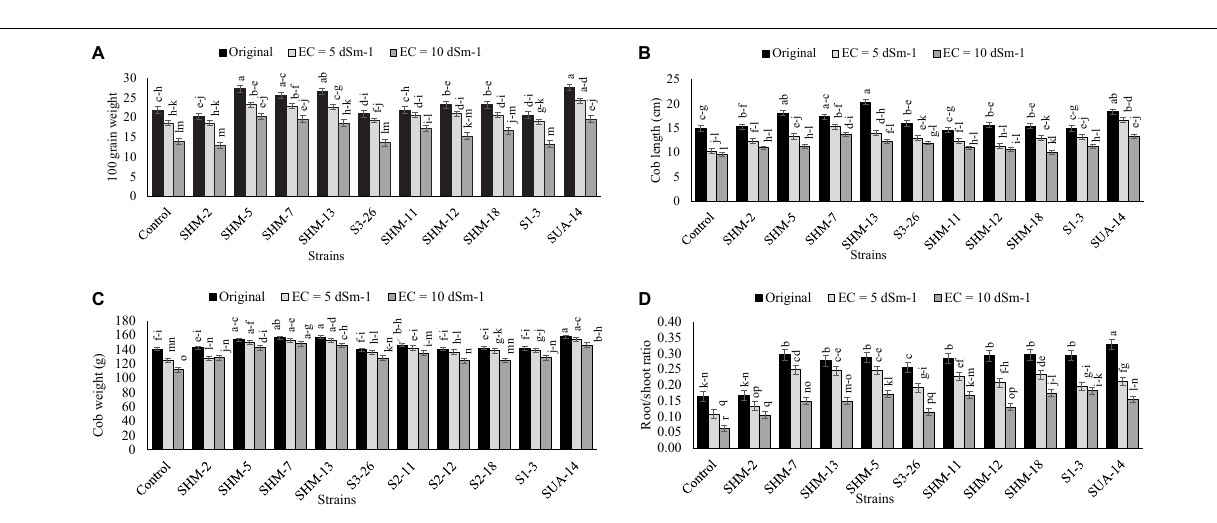
malondialdehyde contents by 20%, respectively, over its corresponding